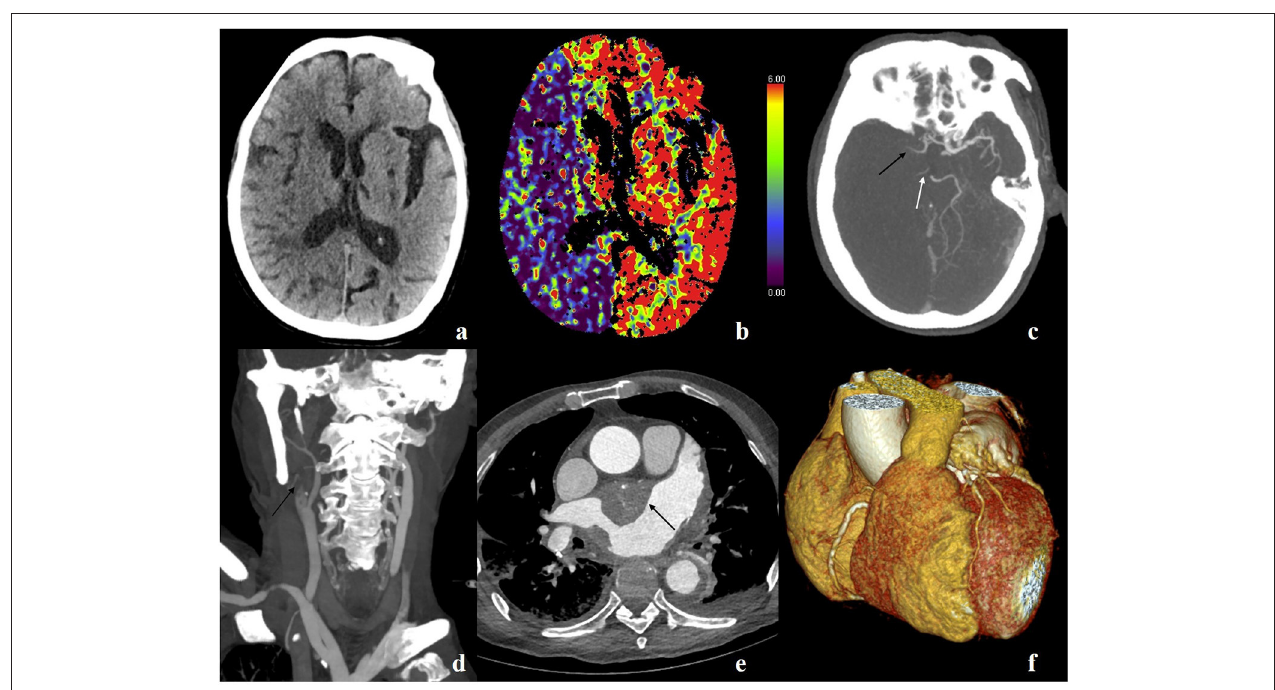
FIGURE 3 | A 73-year-old male, suffered sudden generalized convulsion and unconsciousness for 4h, with a history of hypertension, rheumatic heart disease, and atrial fibrillation. (a) Non-contrast scan shows decreased attenuation in the right hemisphere and blurred gray–white matter boundary. (b) Cerebral blood volume map shows decreased blood volume in the right hemisphere. (c) Maximum intensity projection (MIP) image shows the occluded right middle cerebral artery (black arrow) and posterior cerebral artery (white arrow). (d) MIP image shows occluded right internal carotid artery (black arrow). (e) Axial image shows a massive thrombus in the left atrium (black arrow). (f) VR image of the heart and coronary